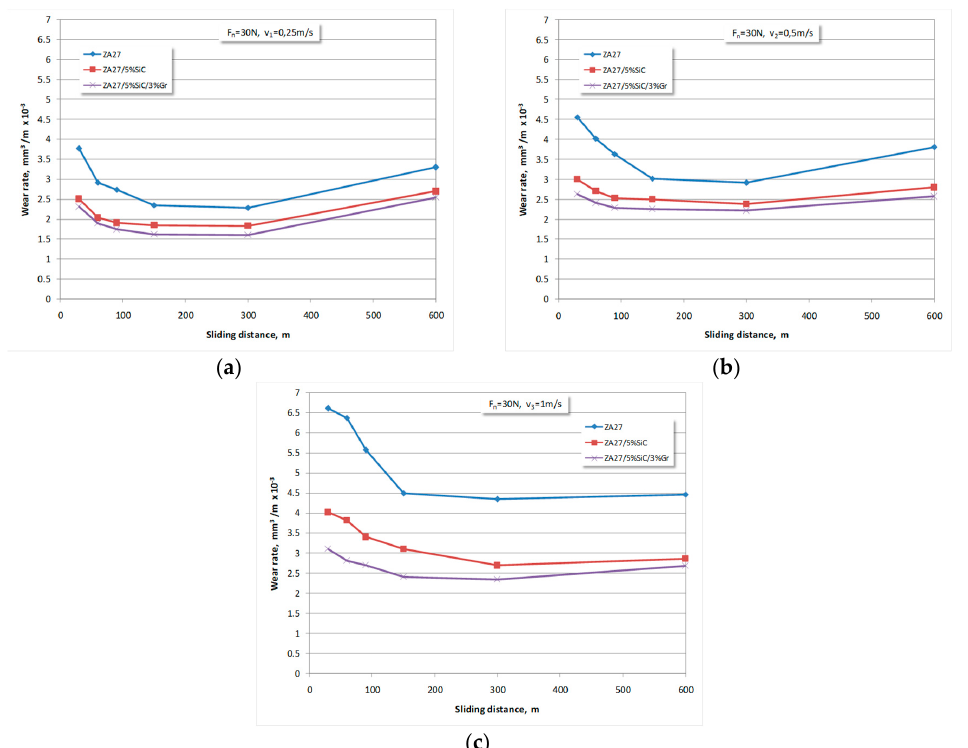
Figure 3. Wear-rate of the tested materials for normal load of 20 N and sliding speed of: ( a ) v = 0.25 m/s; ( b ) v = 0.5 m/s; ( c ) v = 1 m/s.